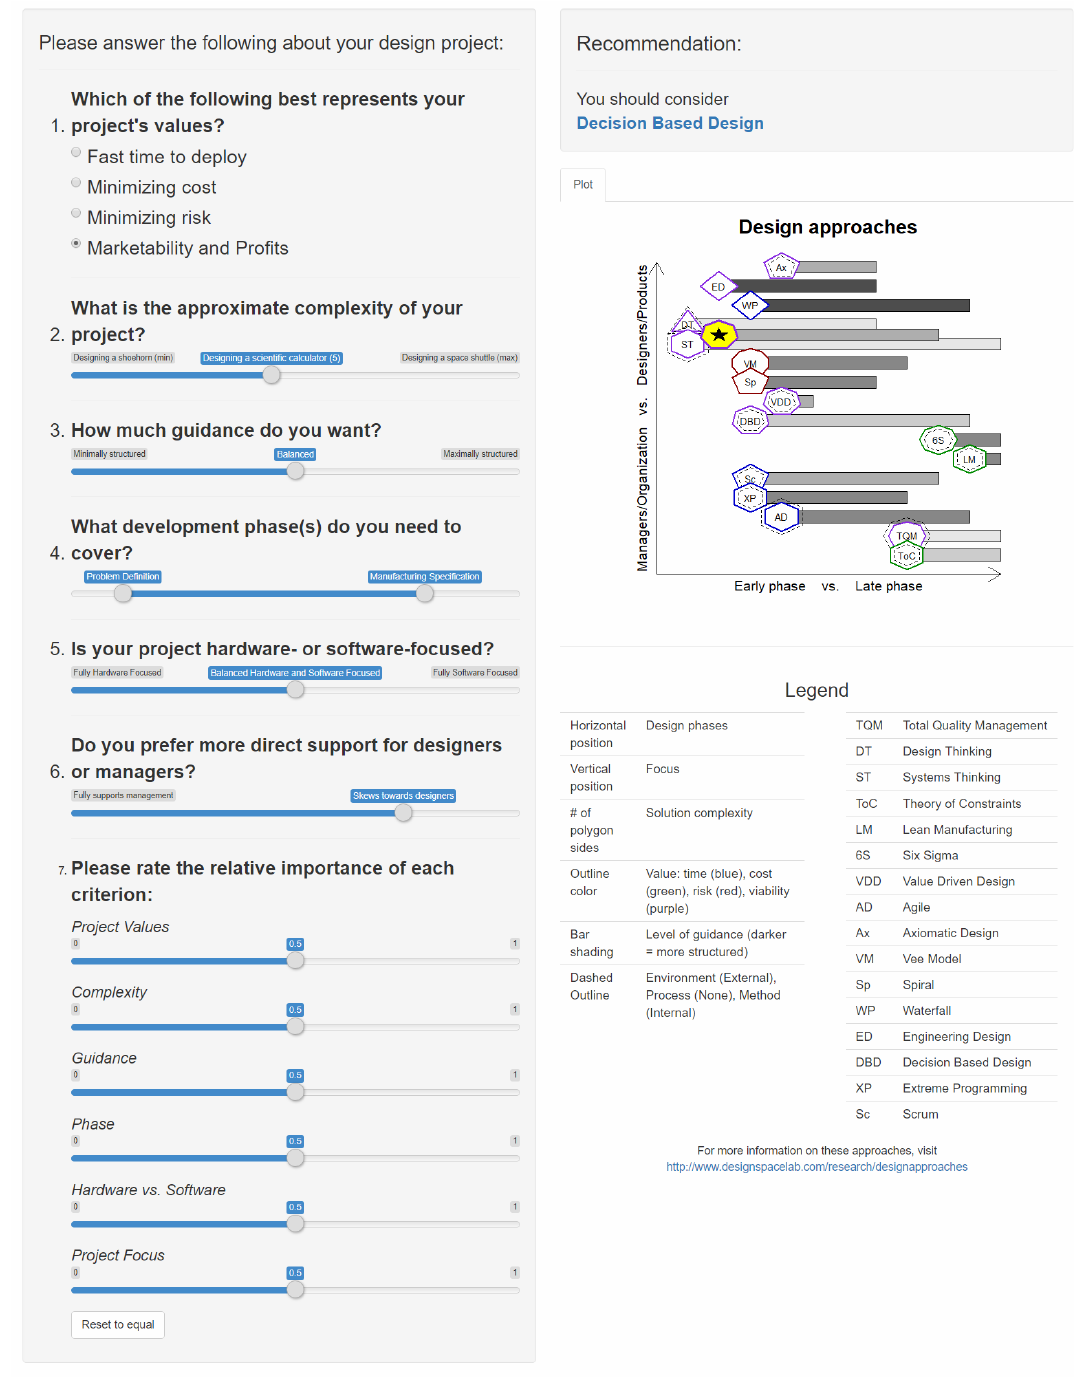
Figure 2. User interface for prototype PD